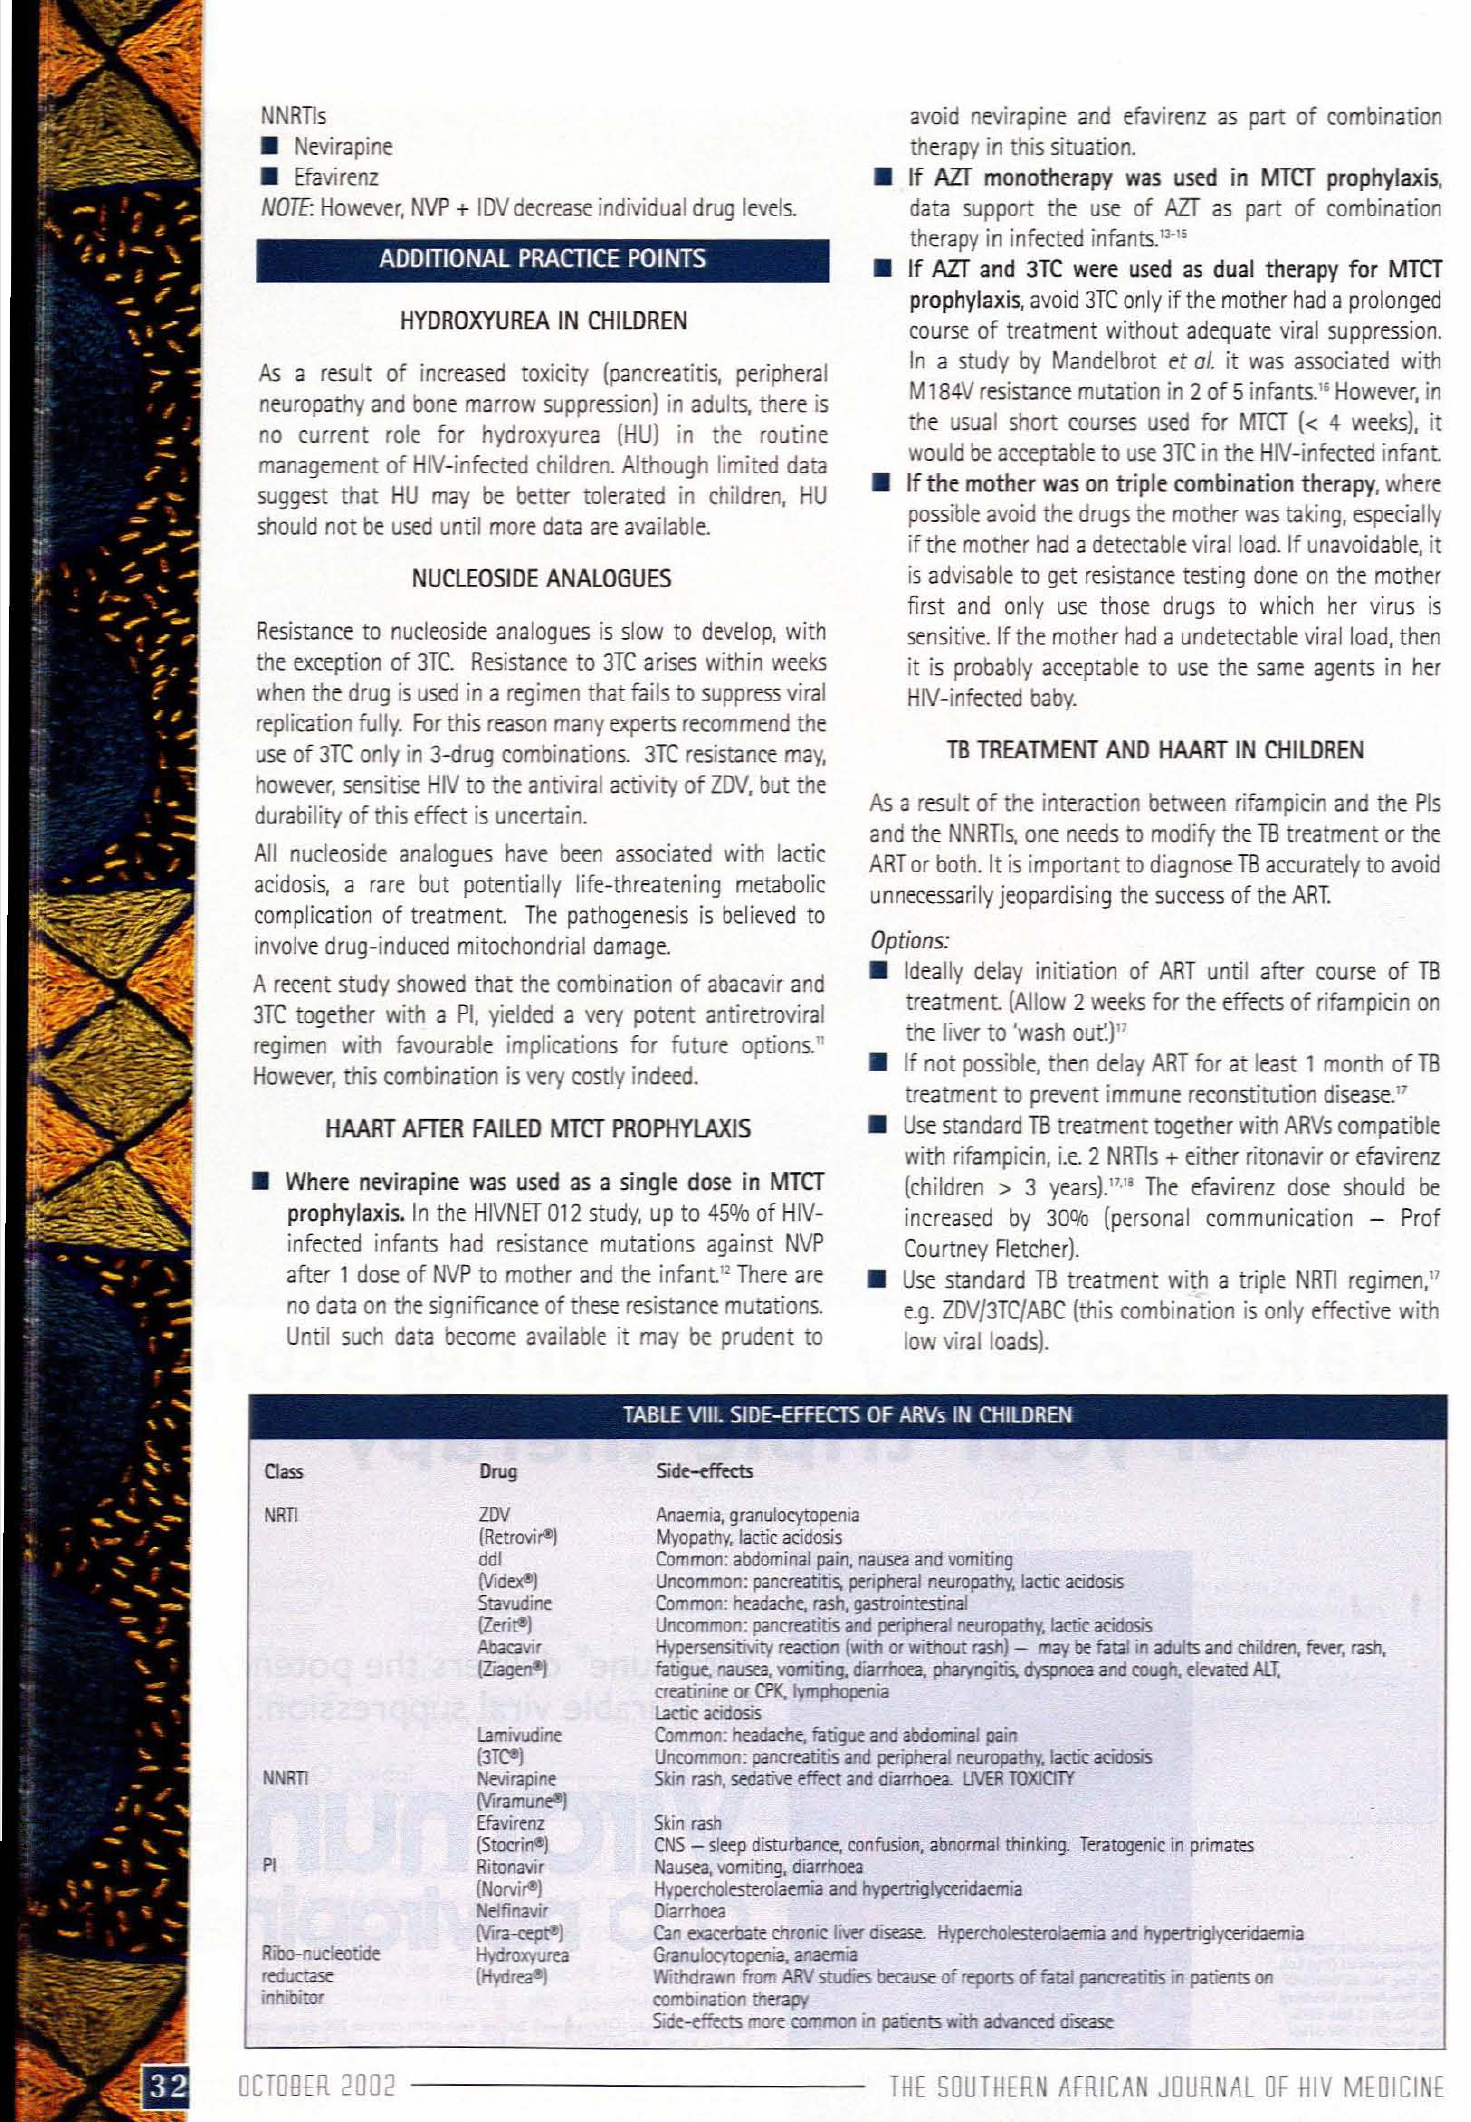
TABLE VIII. SIDE-EFFECTS OF ARVs IN